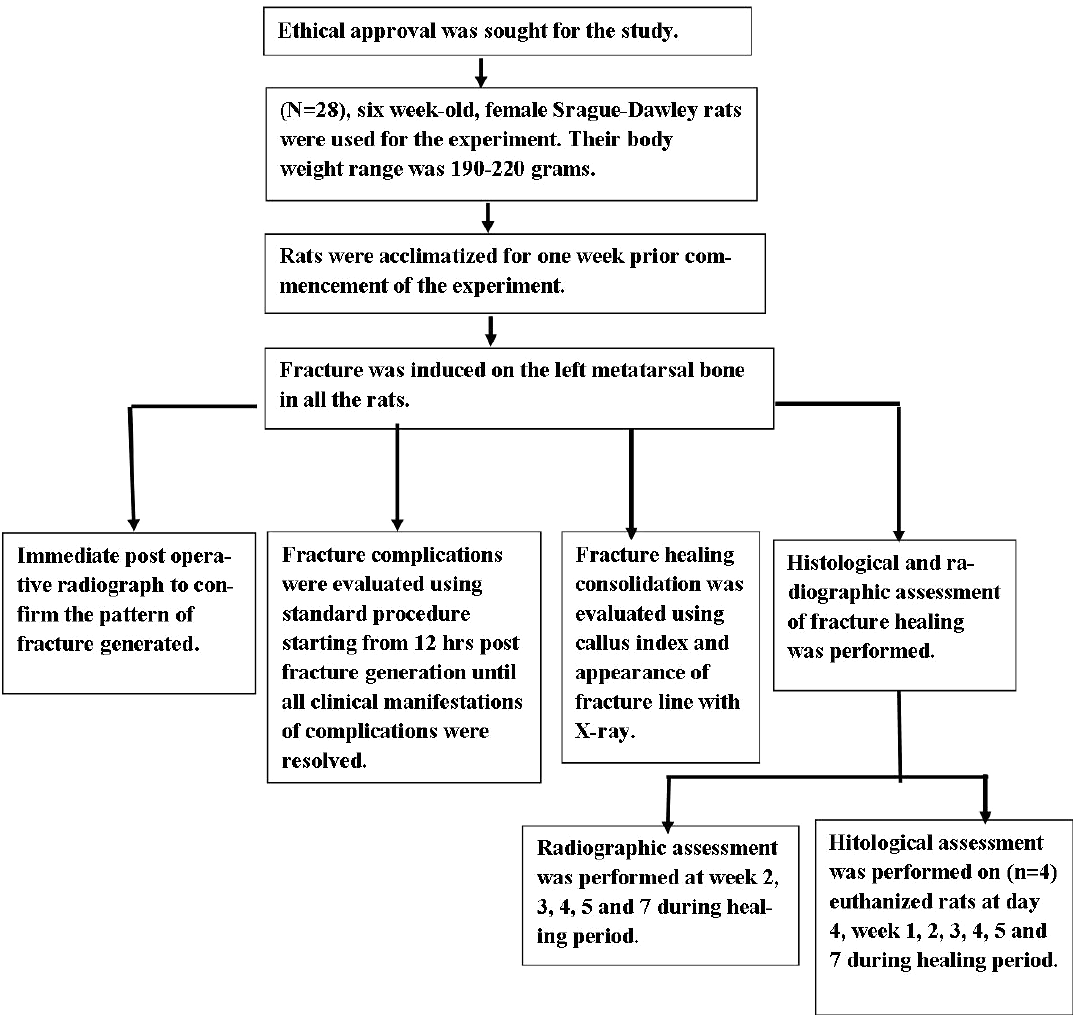
Figure 1. Flowchart of the experimental design, from the ethical approval to completion of the study Each rat was anaesthetised using intramuscular injections of a mixture of ketamine (Ketamine injection, 100 mgmL -1 , Troy laboratories PTY, Australia) and xylazine (Ilium Xylazil 100 mgmL -1 , Troy laboratories PTY, Australia) 70 mgkg- 1 and 7 mgkg- 1 respectively. Tramadol HCl 50 mg (Biolab Co., LTD, Thailand), was